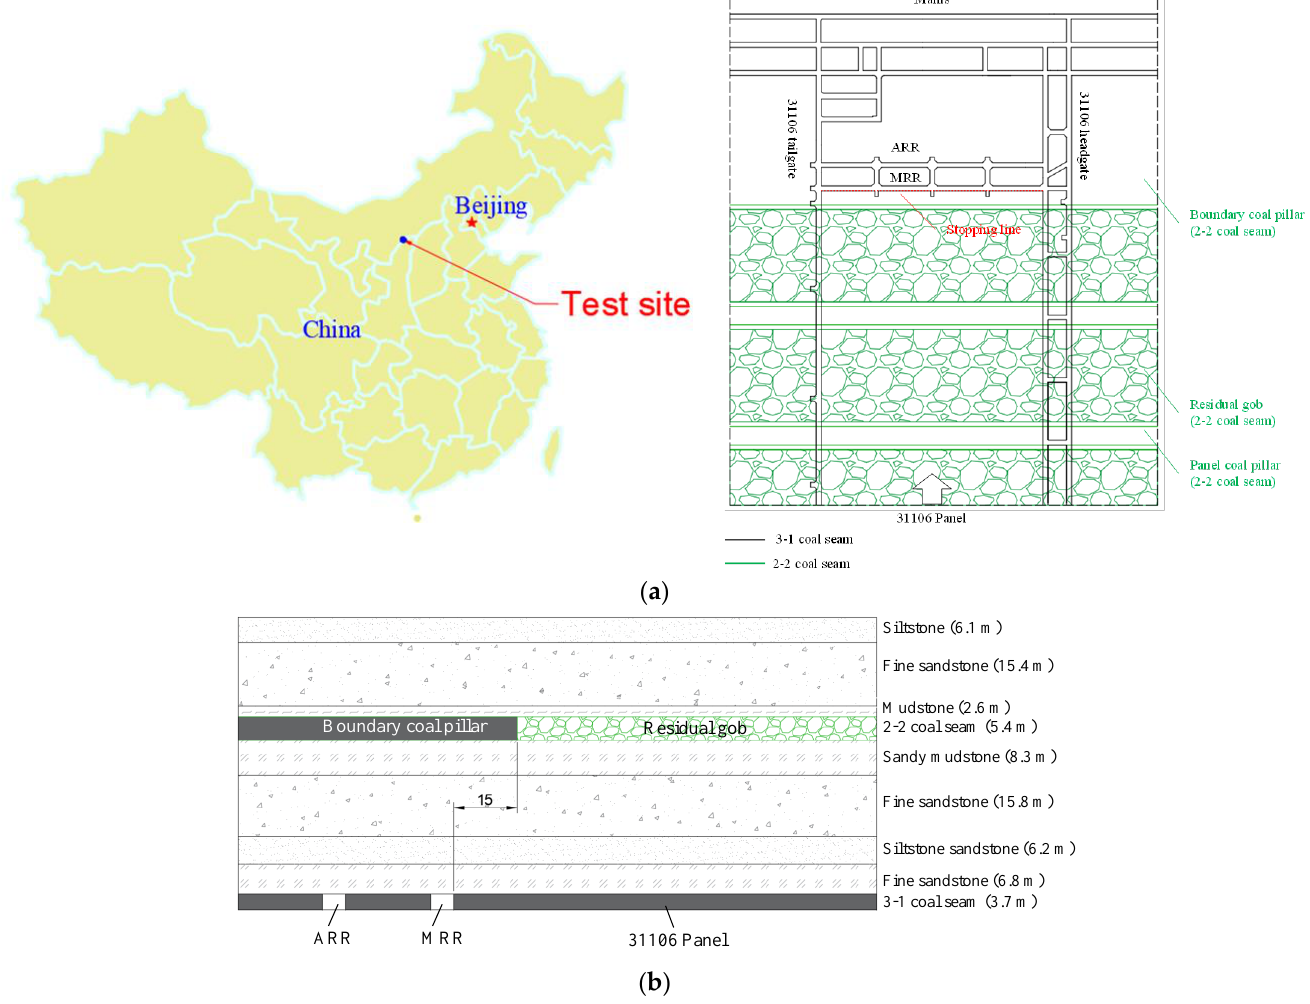
Figure 1. Overview of working face 31,106: ( a ) The layout of the 31,106 panel and 2 – 2 residual coal seam; ( b ) section of the relative position of the retracement roadway and the residual pillar of working face 31,106.